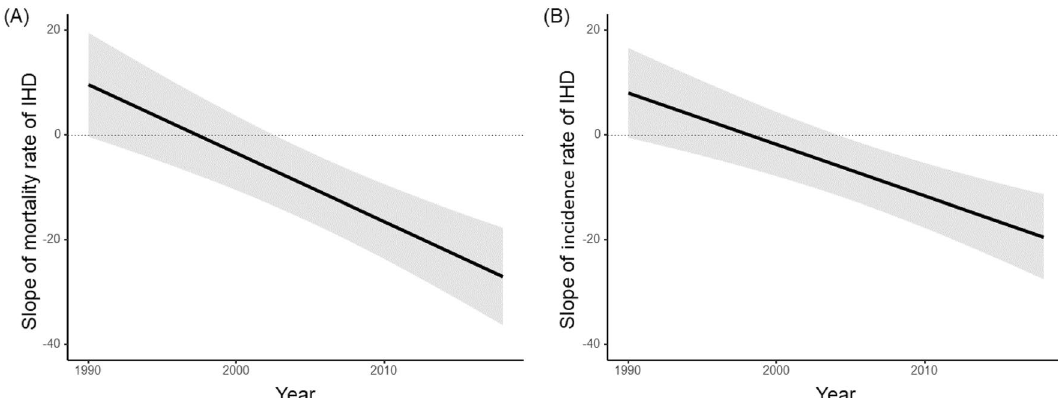
Figure 2. Estimated change in slope and 95% confidence interval of coffee intake to mortality ( A ) and incidence ( B ) rates of ischemic heart disease (IHD) from 1990 to 2018 by mixed-effects model adjusting for